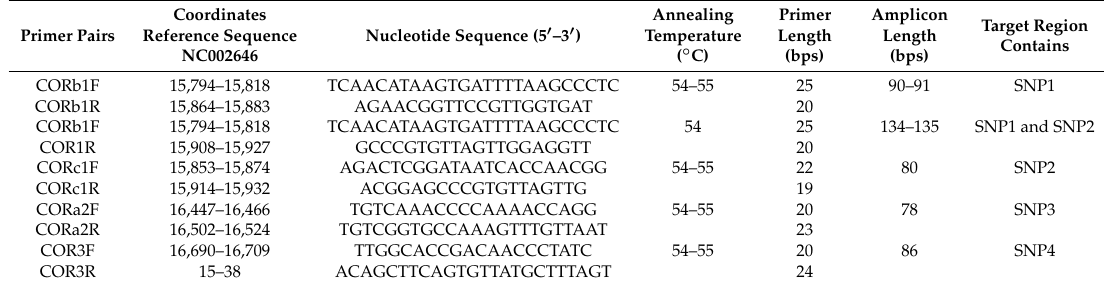
Table 2. Primer pairs used in this